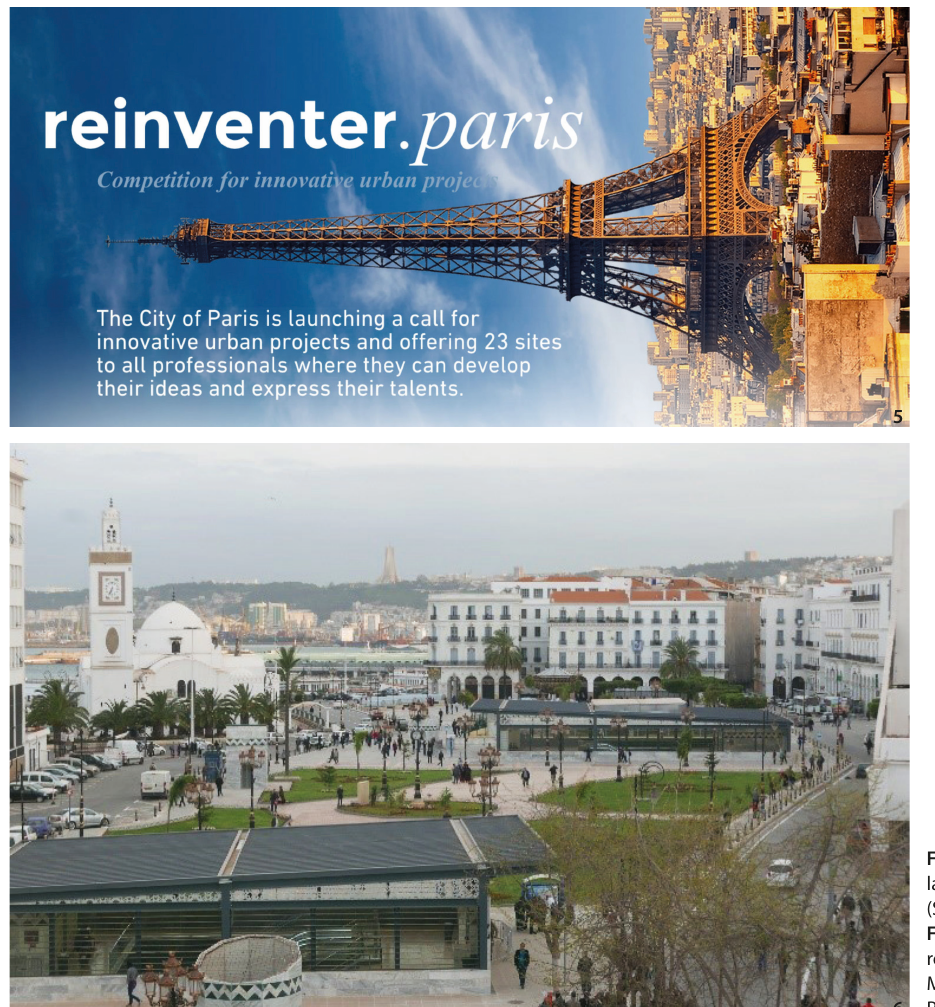
Figure 5 How metropolitan landmarks could reinvent cities (Source: Mairie de Paris). Figure 6 Historic urban centre to represent the metropolis, Algiers Martyrs Square (Source: Mairie de